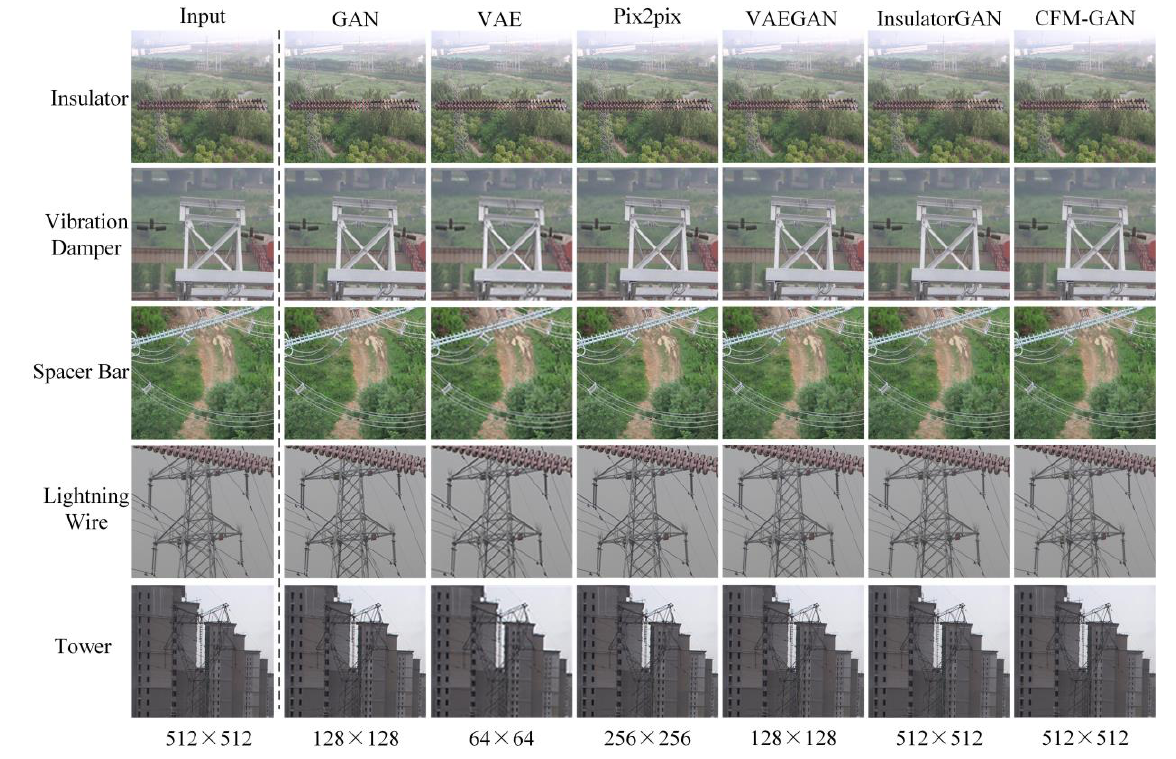
Figure 7. Test instances of each model on CPLID dataset.